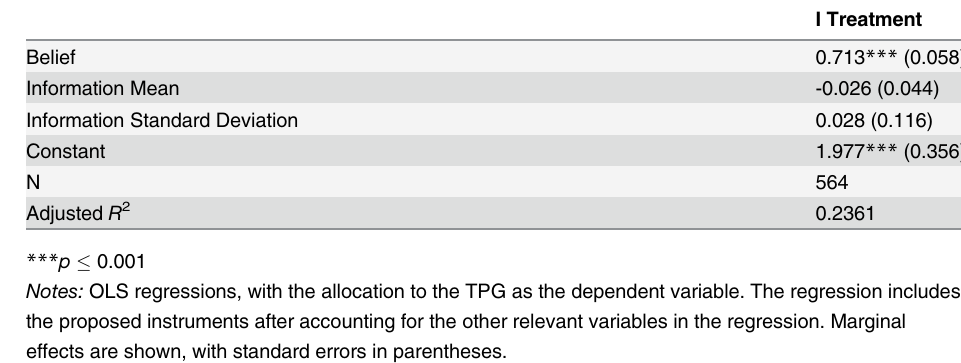
Table 1. Validity: Do Proposed Instruments Independently Impact